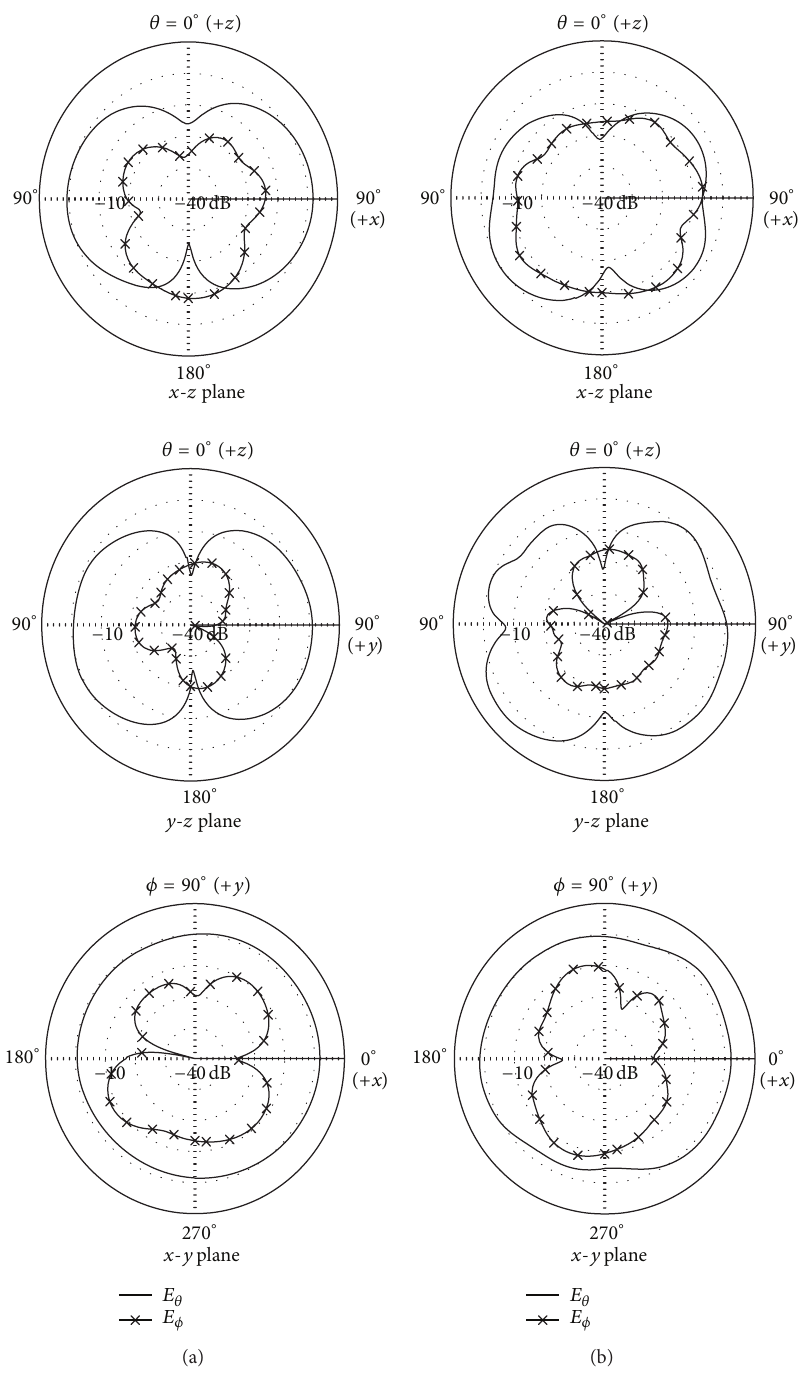
Figure 6: Measured radiation patterns of proposed FC-PIFA obtained at (a) 2.45 and (b) 5.5 GHz.